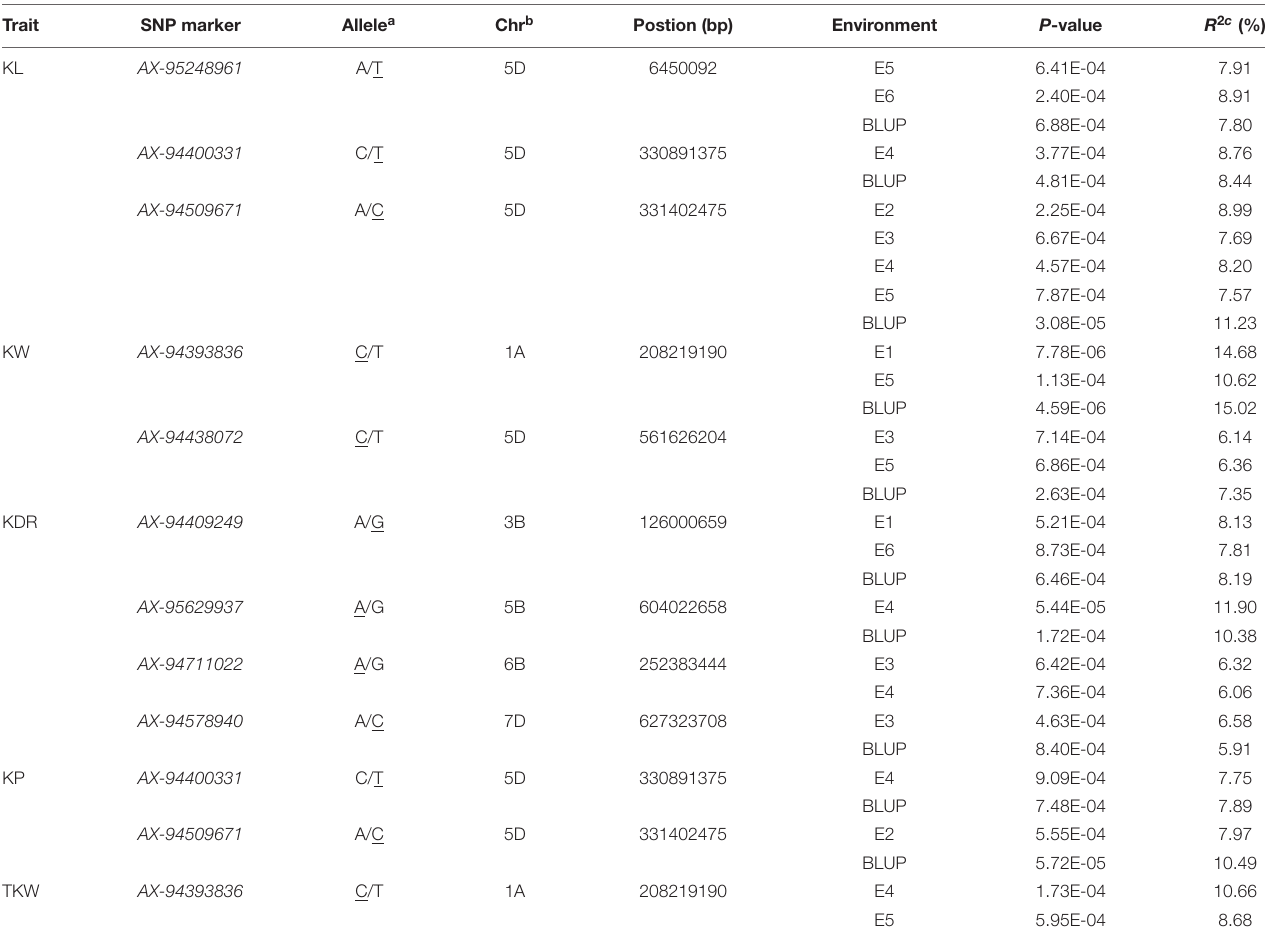
TABLE 2 | Significant marker-trait associations for kernel traits under multiple environments. Trait SNP